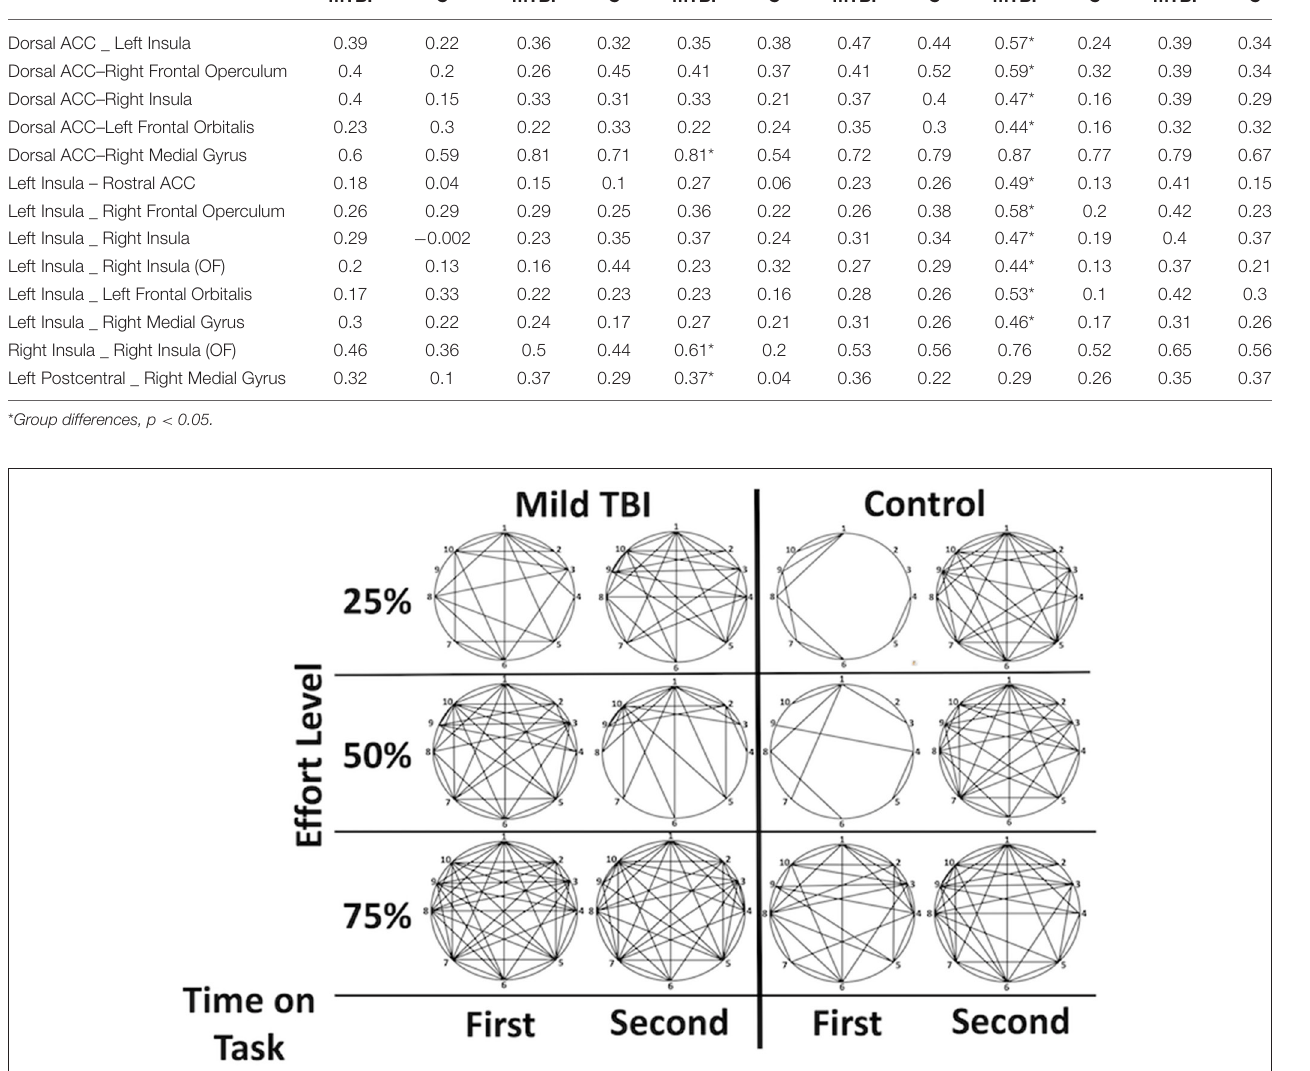
stronger FC between the right posterior medial gyrus and: (1) the dorsal anterior cingulate cortex [ t (100) = 3.12, p FDR = 0.045] and (2) the left postcentral gyrus [ t (100) = 3.123, p FDR = 0.045]